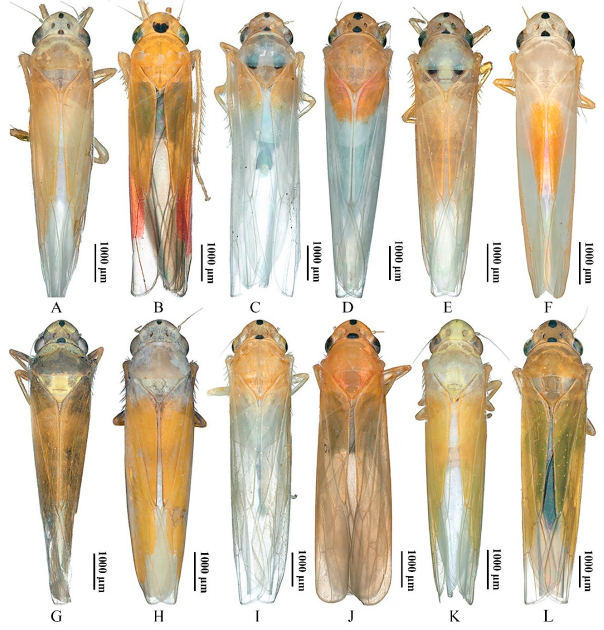
Figure 7. The dorsal views of 12 Atkinsoniella species. ( A ) Atkinsoniella aurantiaca ; ( B ) A . curvata ; ( C ) A . flavipenna ; ( D ) A . longiuscula ; ( E ) A . thalia ; ( F ) A . thaloidea ; ( G ) A . tiani ; ( H ) A . uniguttata ; ( I ) A . warpa ; ( J ) A . wui ; ( K ) A . xanthoabdomena ; ( L ) A . yunnanana . Insects 2022 , 13 , x FOR PEER REVIEW